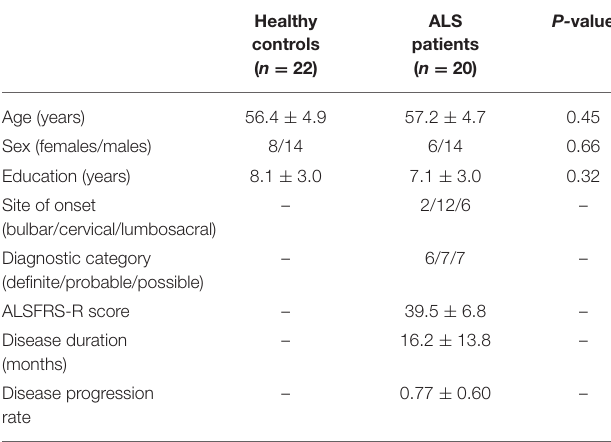
TABLE 1 | Demographic and clinical data of the study participants. Healthy